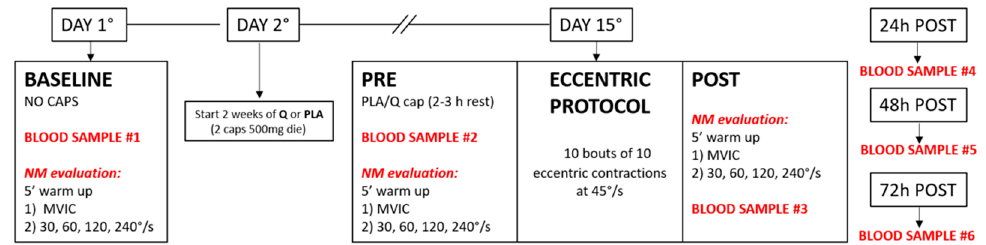
Figure 1. Flowchart of the experimental protocol. NM: neuromuscular.